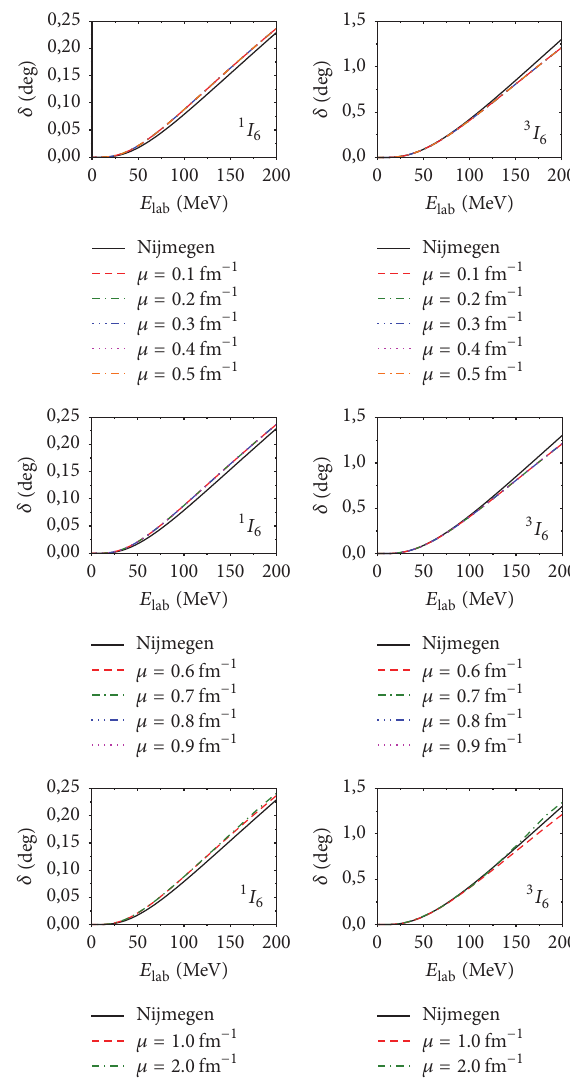
channels and in Figures 11 and 12 for the coupled